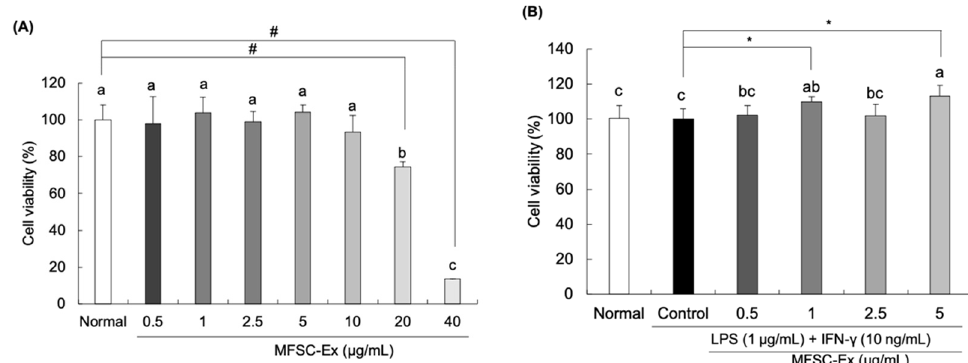
Figure 1. Cytotoxicity of MFSC-Ex on RAW 264.7 macrophage cells in the absence or presence of LPS/IFN- γ . ( A ) Cytotoxic effect of MFSC-Ex on RAW 264.7 macrophage cells. Cells were treated with various concentrations of MFSC-Ex (0.5, 1, 2.5, 5 µ g/mL) for 24 h. ( B ) Effect of MFSC-Ex on cell viability LPS/IFN- γ -stimulated RAW 264.7 macrophage cells. Cells were treated with various concentrations of MFSC-Ex (0.5, 1, 2.5, 5 µ g/mL) for 2 h, followed by LPS (1 µ g/mL) and IFN- γ (10 ng/mL) for 24 h. Values are expressed as means ± SD. a–c Means with the different letters are significantly different ( p < 0.05) by Duncan’s multiple range test. # p < 0.05 vs. normal (un-treated) group, * p < 0.05 vs. control (LPS/IFN- γ -treated)